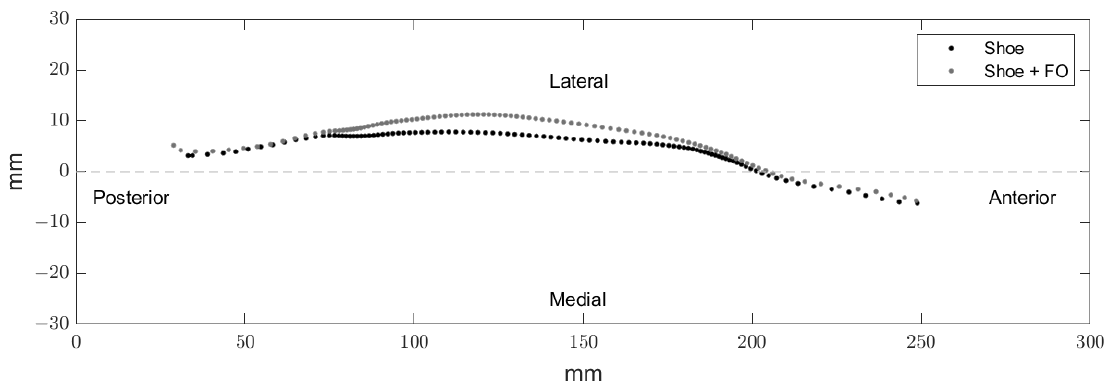
Figure 5. Average center-of-pressure path of two different experimental conditions during level walking. The dashed line represents the long axis of the foot.